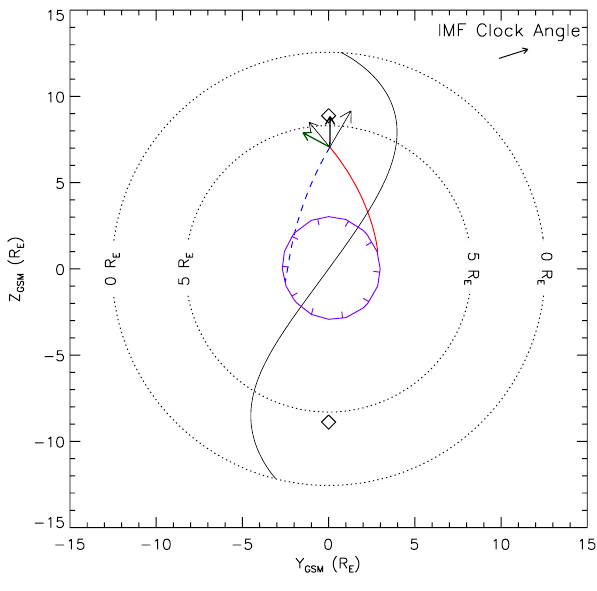
Fig. 7. An example model run: 22 February 2003, 01:23 UT. The figure shows a view of the model magnetopause projected into the GSM Y-Z plane, with concentric dotted circles marking contours of X GSM ; the cusps are considered to be point singularities marked by diamonds. The boundary at which the model magnetosheath flow becomes super-Alfv´enic is marked by a purple contour, with tick marks pointing to the direction in which the flow is sub-Alfv´enic. A model subsolar component reconnection line (thin black line) has been initiated at (R mp , 0 , 0 ) GSM and traced perpendicular to ( B ms − B gm ) for 20 R E in each direction. The position and veloc- ity of the observed FTE have been projected onto the model magne- topause. The projected observed FTE velocity ( V projected ) is shown as a green arrow. The model velocities for flux tubes connected to the Northern and Southern Hemispheres ( V HTN and V HTS ) have also been calculated using the model magnetosheath magnetic field and flow speed at the projected position (black arrows). The model flux tube paths have been traced backward for 750s (red line: flux tubes connected to Northern Hemisphere; blue line: connection to Southern Hemisphere). Also shown as a black arrow is the model (radial) magnetosheath